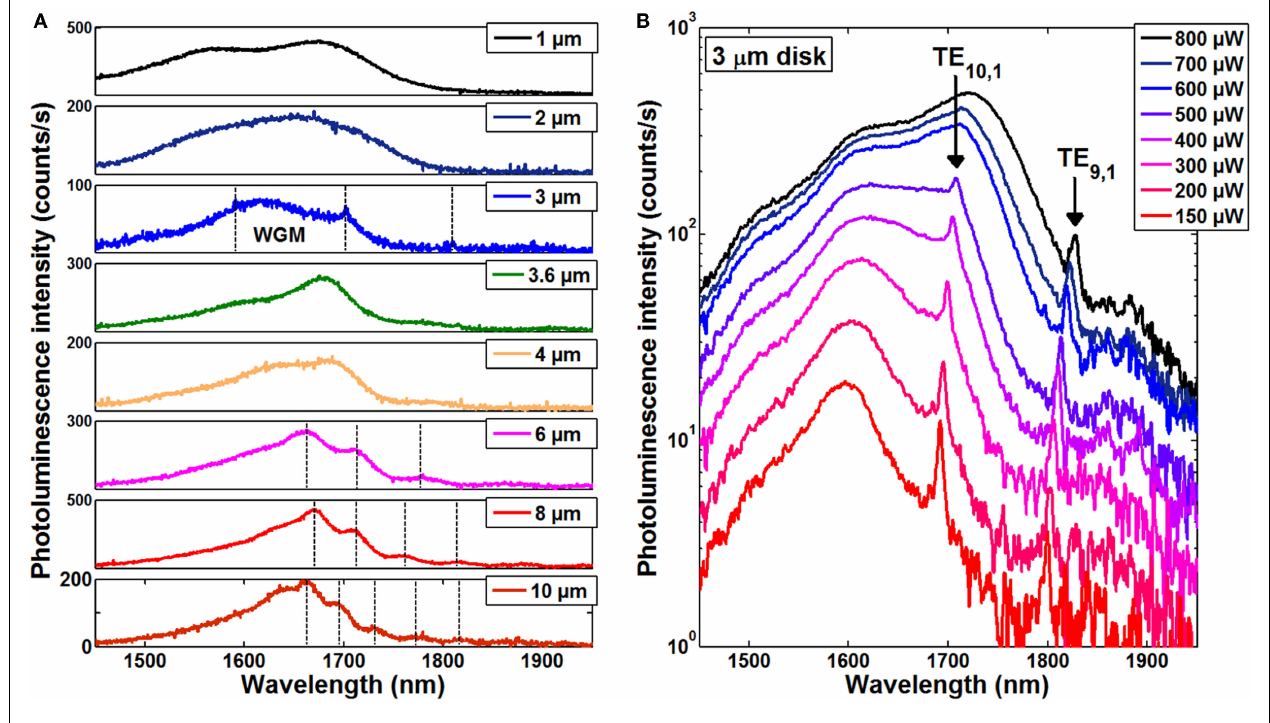
FIGURE 7 | (A) Photoluminescence spectra of Ge micro-disks on suspended SiO 2 beams with different diameters ranging from 1 µ m to 10 µ m using 400 µ W excitation power, WGM are observed in the 3 µ m disk spectrum, while broad-peak resonances are observed for 6, 8, and 10 µ m disks.